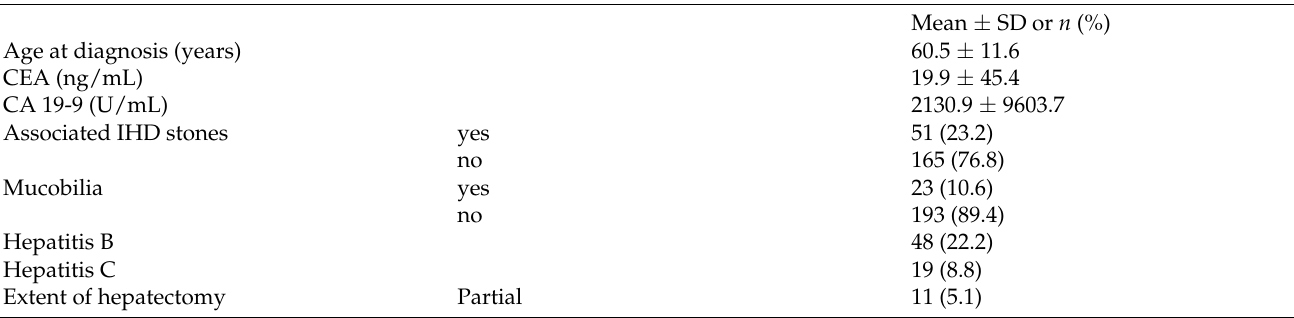
Table 1. Clinicopathological characteristics of 216 patients with intrahepatic cholangiocarcinoma achieving curative